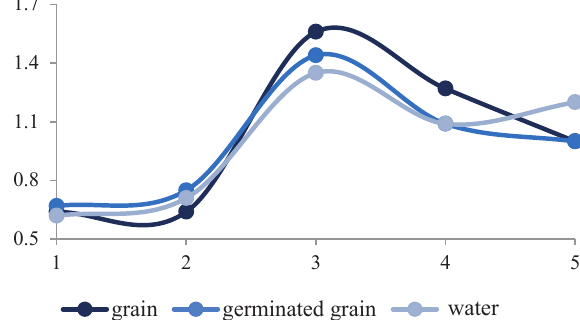
Figure 5 Spectra of identification parameters for grain and water. The X-axis indicates the numbers of identification parameters, the Y-axis indicates their values